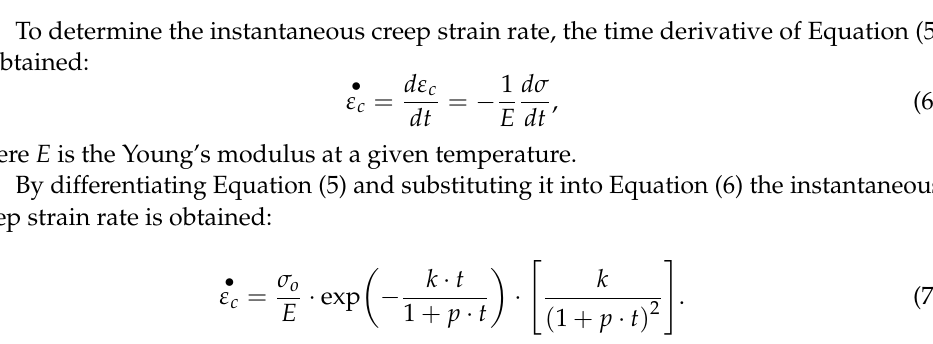
Figure 15. Stress relaxation curves of the DLD-processed Ti-6Al-4V alloy for ( a ) 700 °C and ( b ). 500 °C.